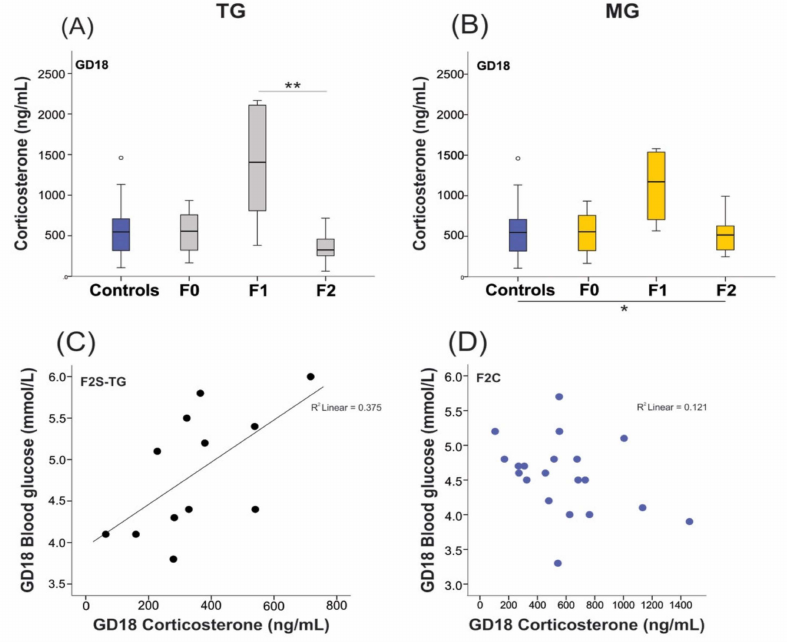
Figure 5. Elevated plasma corticosterone (CORT) levels in F1 animals of TG and MG stress groups. CORT levels were significantly elevated in the F1 dams of the TG ( A ) and MG ( B ) groups on GD18 but returned to baseline levels in the F2 generation. ( C ) Higher CORT levels on GD18 were associated with increased blood glucose levels in the F2 generation of the TG group. ( D ) No correlation was found between CORT and glucose levels in F2 controls. Asterisks indicate significance: * p < 0.05; ** p < 0.01. Controls n = 20–28; F0 n = 10–11; F1 n = 6–8, F2 n = 10–12. Box plots mid-lines indicate medians, whiskers indicate min-max values, and boxes indicate interquartile